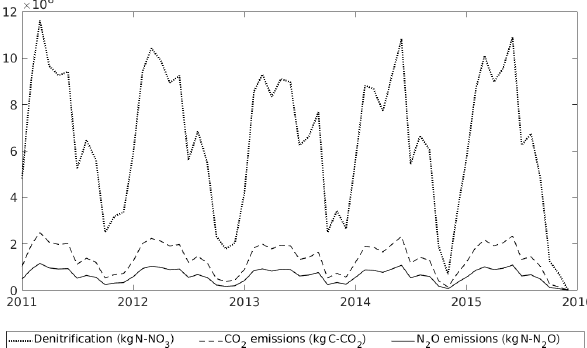
Figure 5. Monthly denitrification (kgN-NO 3 ) and CO 2 (kgC-CO 2 ) and N 2 O (kgN-N 2 O) emissions over the entire Amazon watershed for the period 2011–2015.